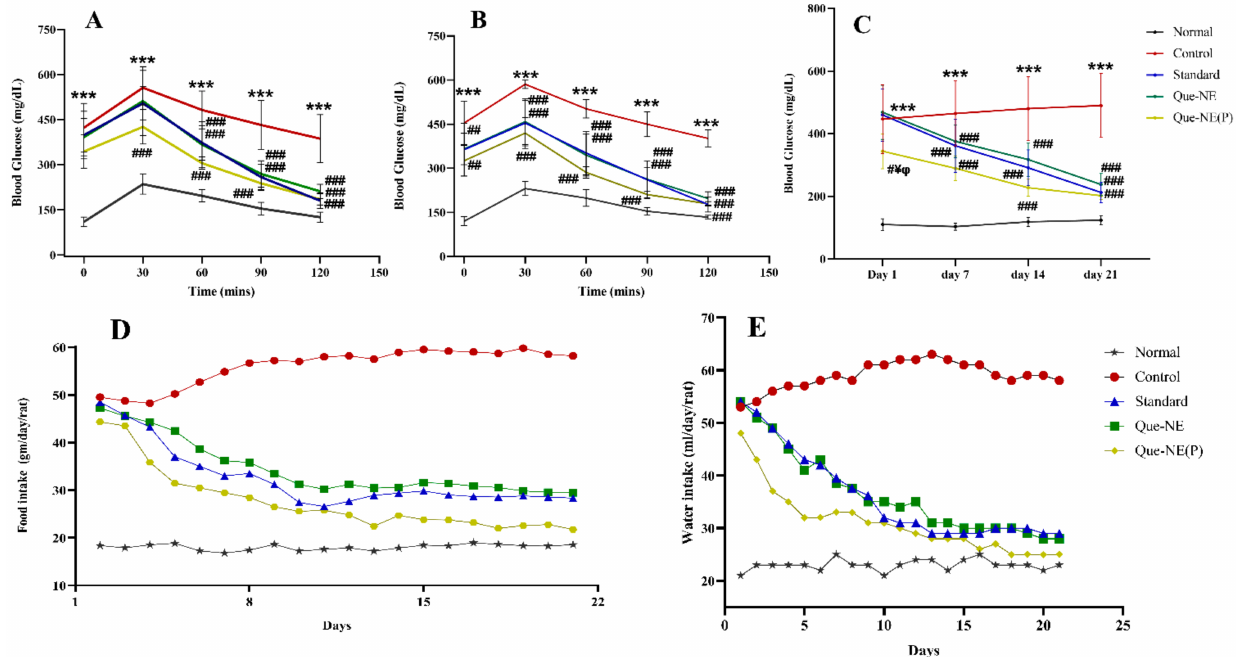
Figure 8. Effects of Que-NE and Que-NE (P) on: ( A ) oral glucose tolerance test on the 10th day; ( B ) oral glucose tolerance test on the 20th day; ( C ) blood glucose level (BGL); ( D ) food intake; ( E ) water intake. Data presented are the mean ± standard deviation. Significance was measured using one-way ANOVA: *** p < 0.001 vs. Normal group. # p < 0.05, ## p < 0.01, and ### p < 0.001 vs. Control group. ¥ p < 0.05 vs. Standard group, and ϕ p < 0.05 vs. Que-NE treatment ( n =